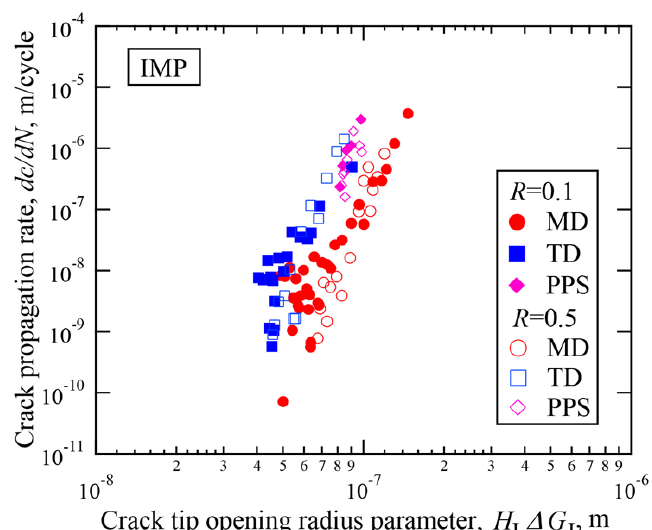
Figure 6: Relation between crack propagation rate and crack-tip opening parameter.